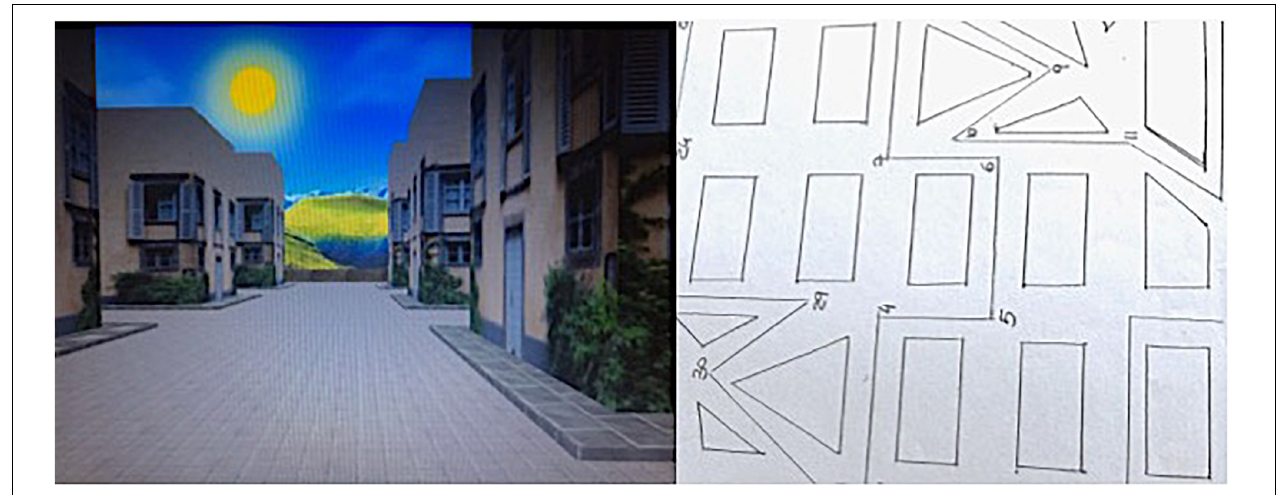
FIGURE 1 | Snapshots of VR-RMT and M-RMT used in the